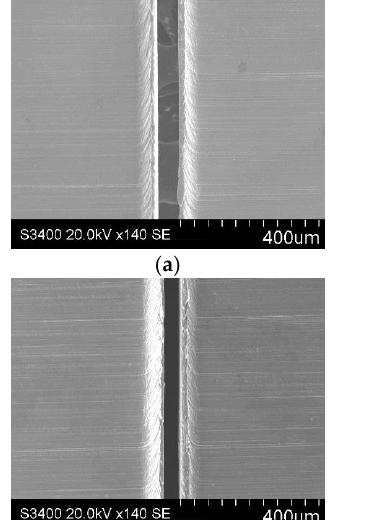
Figure 6. The tiny bulge near the machined region. Figure 5. SEM micrographs of slits machined using different initial and secondary velocities: ( a ) 10